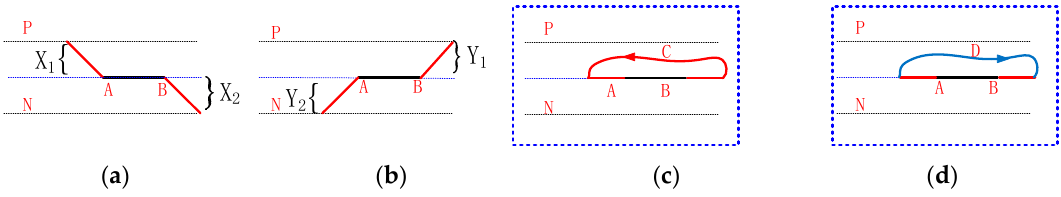
Figure 7. Four modes based on the unified topology under USPWM. ( a ) PC mode; ( b ) NC mode; ( c ) PF mode; ( d ) NF mode.